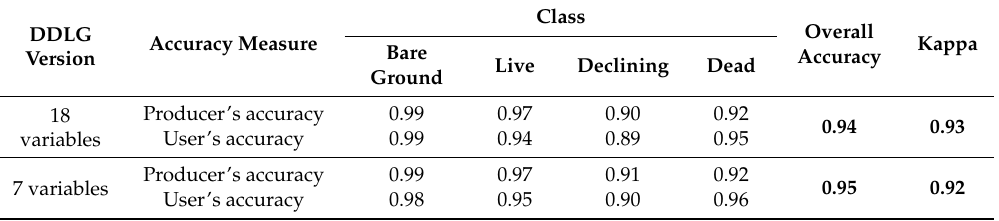
Table 4. Results of the “pure classes” validation for the DDLG model with both 18 and 7 selected variables, respectively, measured by producer’s, user’s, and overall (in bold) accuracies as well as Cohen’s Kappa. Confusion matrices are presented in (Table